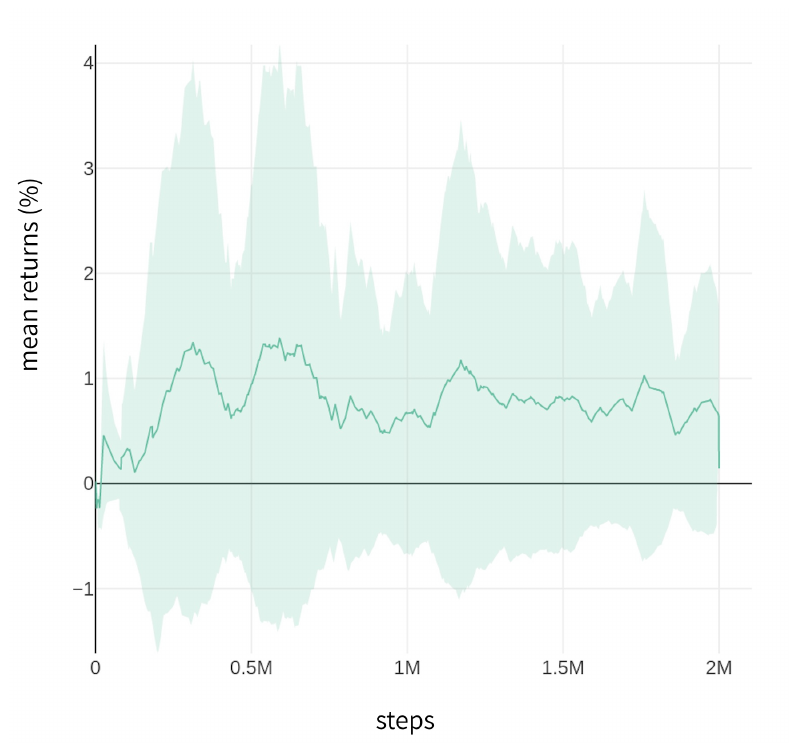
Figure 5. SAC on 4 sessions.